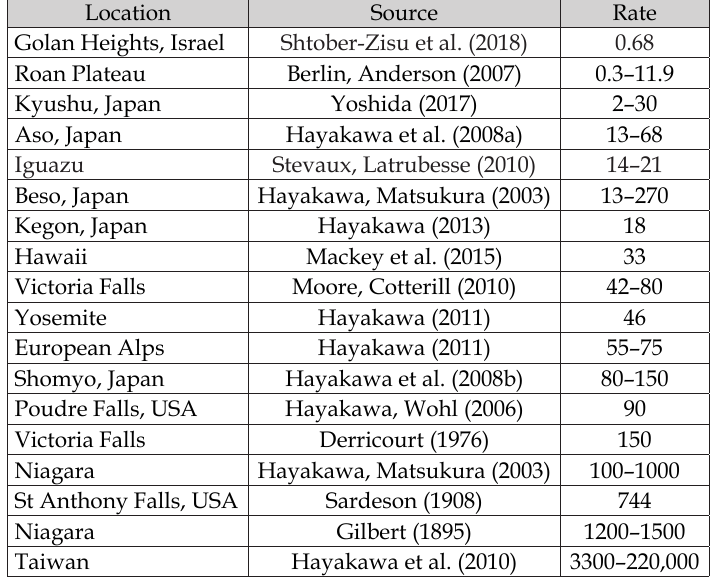
Table 3. Rates of waterfall recession ordered according to the rate in millimetres per